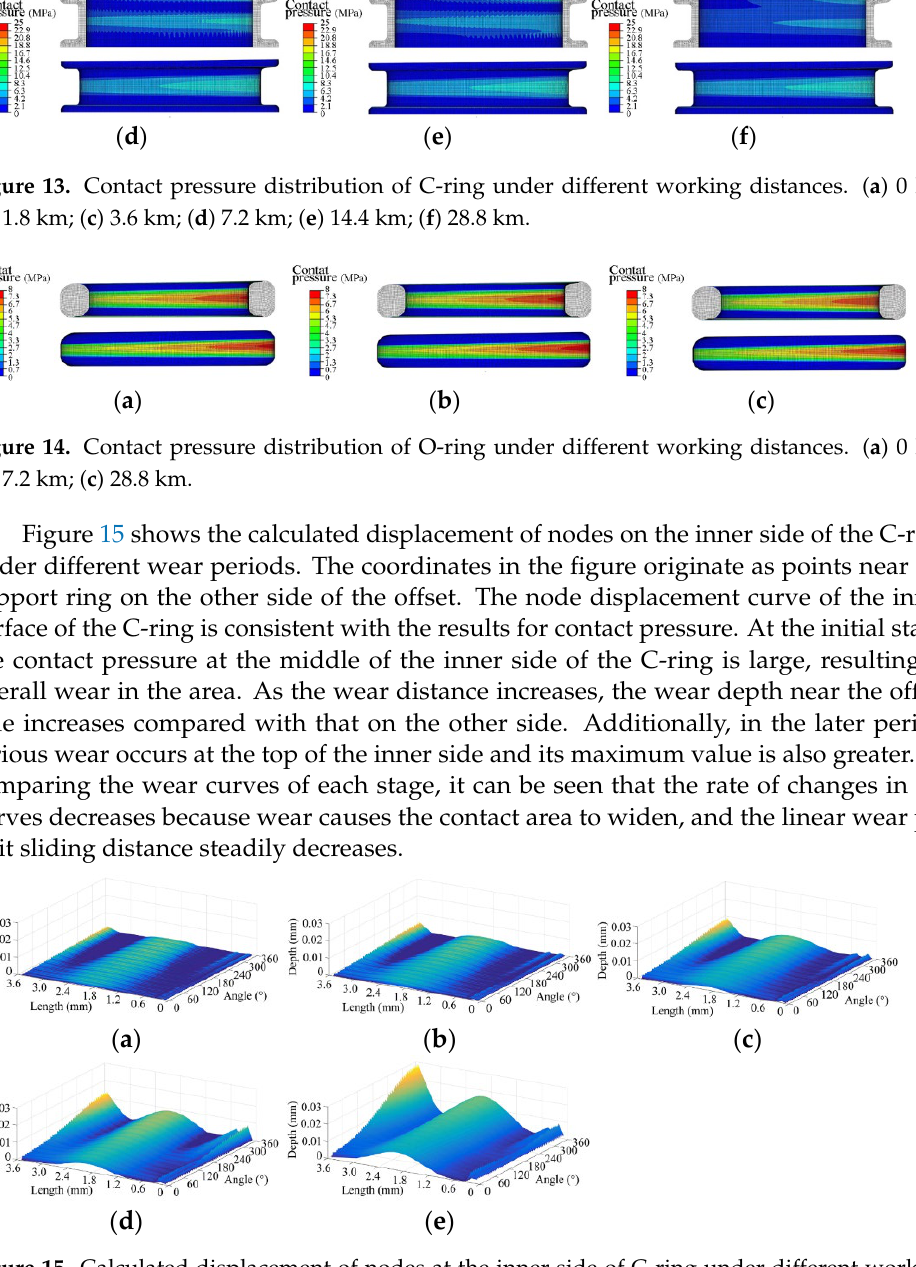
( b ) Figure 16. Inner side surface contact state of C-ring under different working distances. ( a ) 0 km; ( b ) 14.4 km. 5.3. Effects of the Working Conditions Under the action of different gas pressures and pre-compression rates, the defor- mation and stress state of the Cap-seal are different and the wear condition is affected differently. Figure 17 shows the maximum contact pressure, the maximum mises stress, the wear volume, and effective contact surface rate of the C-ring under a gas pressure of 5 MPa and of 2 MPa. The compression rate was set to 15%. As shown in Figure 17a, the increased gas pressure increases the contact pressure at the initial stage and increases the range for a drop in pressure during wear, and this change is more obvious on the offset side. It also can be seen that when the gas pressure is 5 MPa, the stress of the C-ring in- creases significantly during operation, which shows an increased risk of seal damage. As